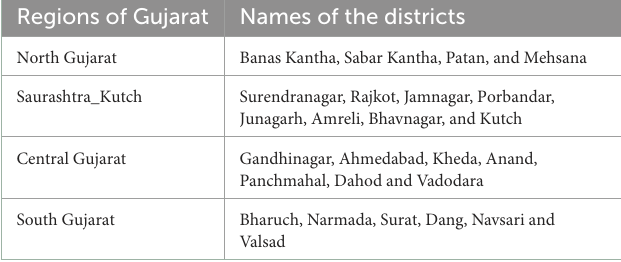
TABLE 1 Regions of Gujarat with their district